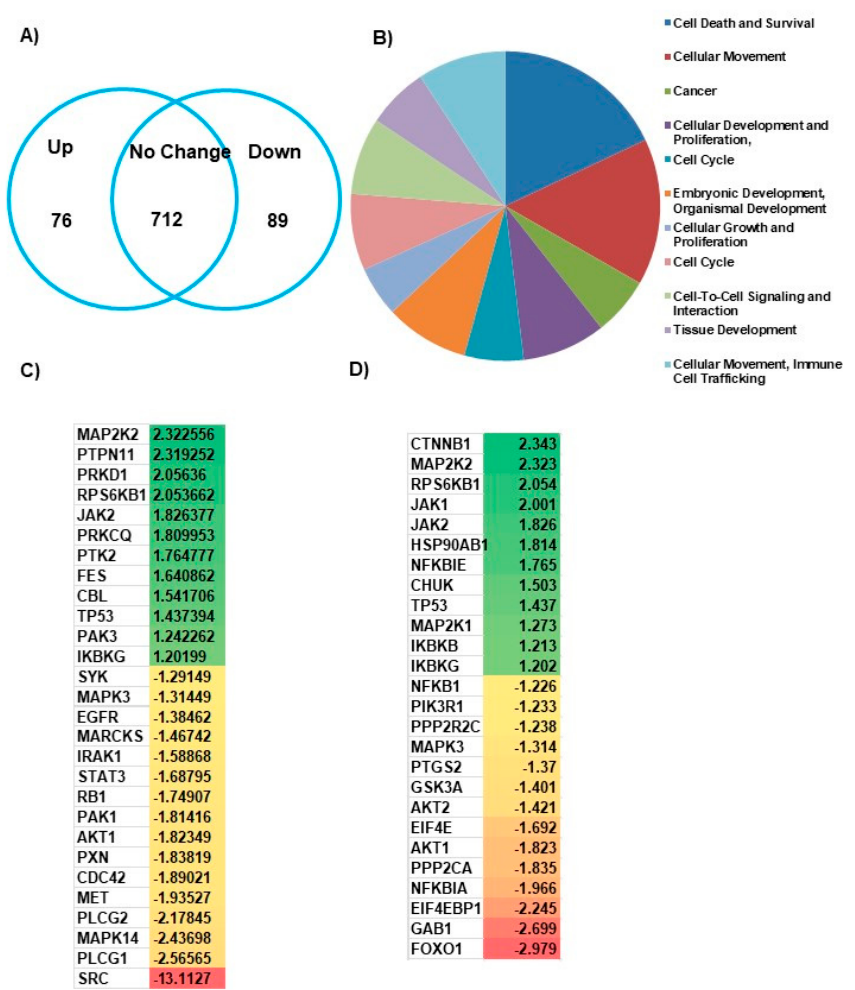
Figure 3. CDC42SE1 regulates cell proliferation through Akt pathway in A431 cells. ( A ) A431 SE1 and A431 Ctrl cell lysates were labelled and analyzed using Kinex™ antibody array, which interrogated expression levels or phosphorylation status of 877 cell signaling proteins. Protein expression was upregulated by ≥ 1.2-fold or downregulated by ≤ 1.2 is presented in the Venn diagram. The fold changes in expression were calculated using Ingenuity Pathway Analysis (IPA). ( B ) Pie chart representing gene ontology classification of Kinex™ antibody array based on biological functions. ( C ) The heat map diagram represents the inhibition of neoplastic cell growth in data generated from A431 SE1 and A431 Ctrl using IPA software. ( D ) The heat map diagram represents the Akt pathway proteins, which are differentially expressed in A431 SE1 cells compared to A431 Ctrl cells, as predicted by IPA